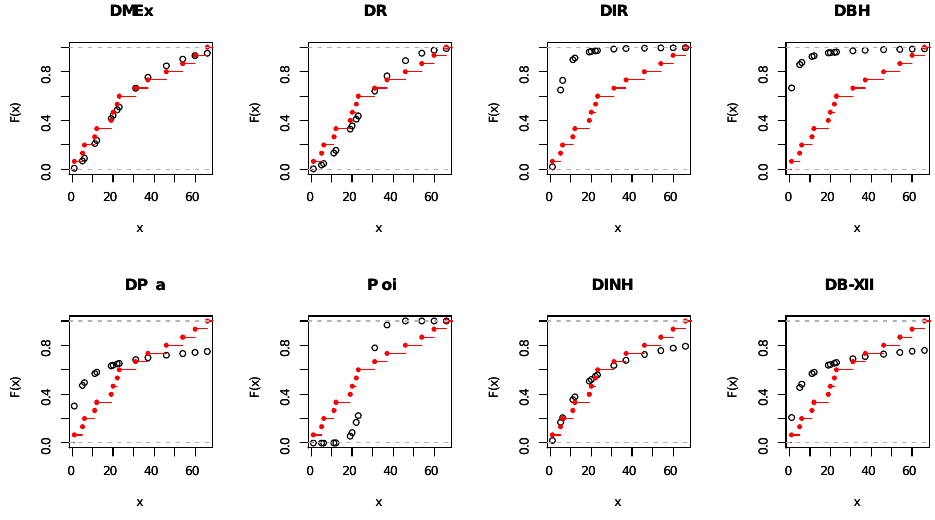
Figure 9 . Empirical CDFs visualization plots for EC data. Figure 9. Empirical CDF visualization plots for EC data.